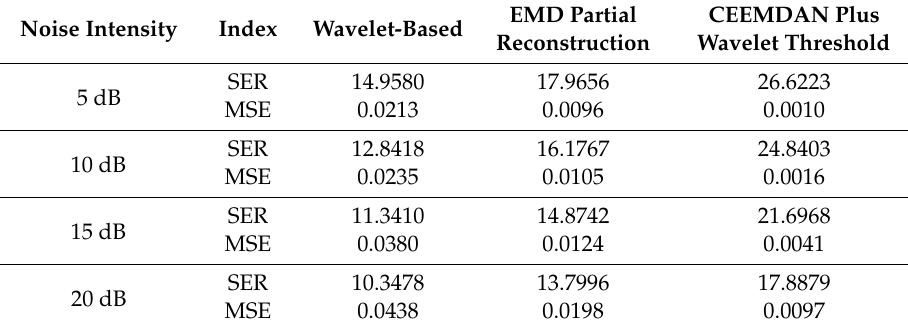
Figure 7. Synthetic noisy ECG with baseline wander de-noising results (No. 100 MIT–BIH ECG). Table 4. Performance indices under different noise intensity (No. 100 MIT–BIH